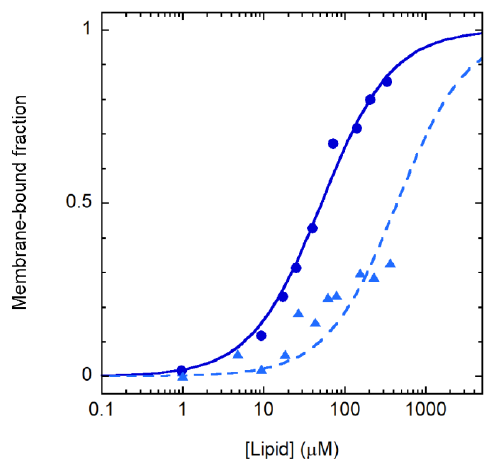
Figure 3. Crabrolin21 binding to membranes. Crabrolin21/membrane association followed through the peptide CD signal at 197 nm for POPE/POPG (7:3 molar ratio) or POPC/cholesterol vesicles (1:1 molar ratio) (blue circles and light blue triangles, respectively). Crabrolin21 concentration: 11 μM. Measurements were performed at 298 K and pH 7.4.